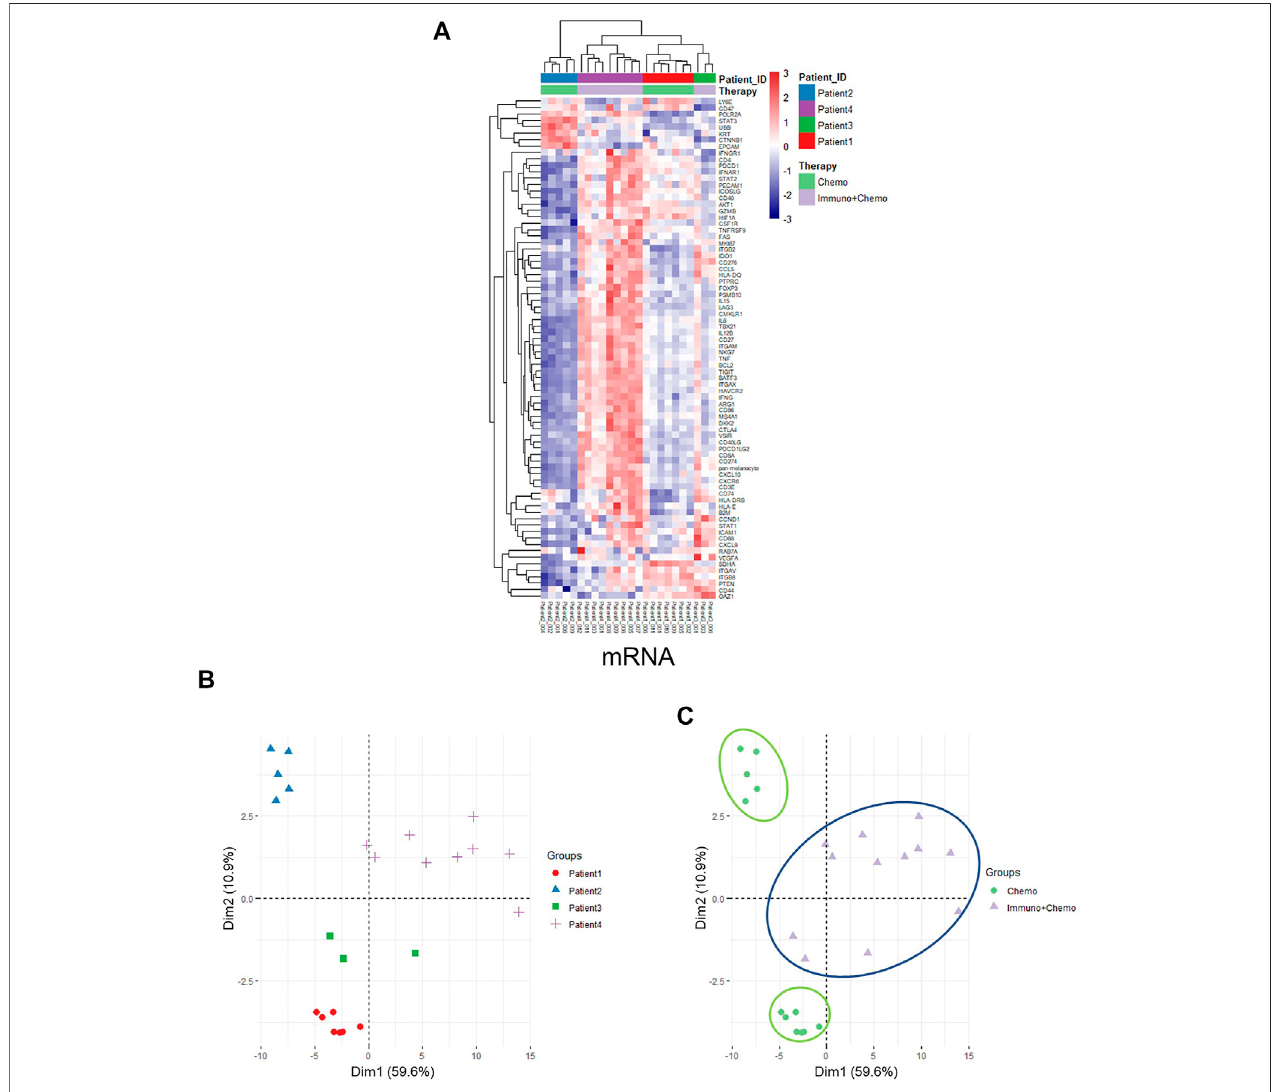
FIGURE 5 | Unsupervised hierarchical clustering and PCA of tumor regions based on mRNA expression. (A) Unsupervised hierarchical clustering of mRNA expression in the tumor ROIs of chemotherapy or combinational therapy patients. ROIs are grouped based on treatment options and patient IDs. (B,C) PCA plots of mRNA expression in the tumor ROIs grouped by patients (B) or therapies (C) , respectively.